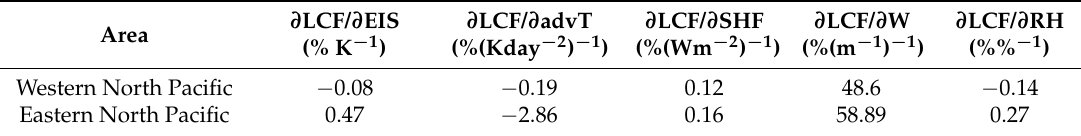
Table 1. Regression slope for each predictor (EIS: estimated inversion strength; advT: